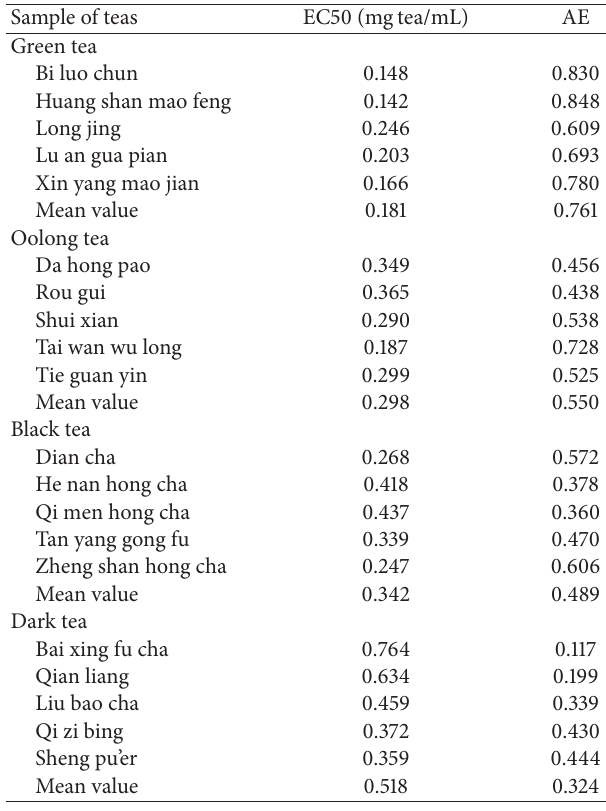
Table 4: EC50 values (concentration causing 50% inhibition) and anti-DPPH radical efficiency (AE) by tea